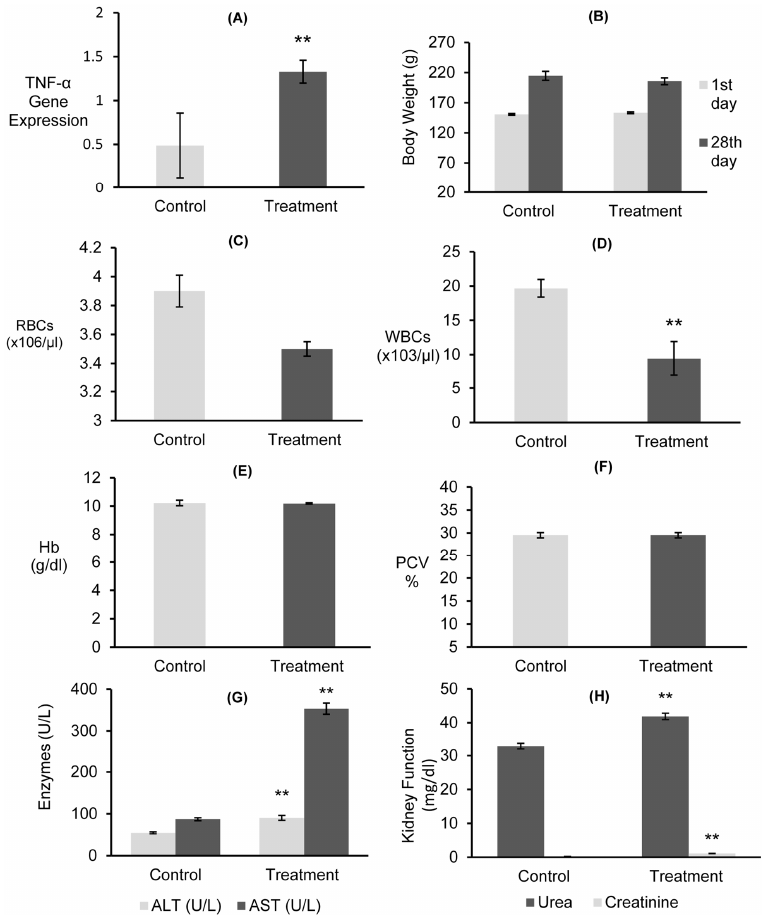
Figure 6. Toxic effects of the crude extract of combined Alternaria mycotoxins (ALT, AOH, TeA, and AS) on TNF- α gene expression ( A ), body weight ( B ), red blood cells (RBCs) ( C ), white blood cells (WBCs) ( D ), hemoglobin (Hb) ( E ), packed cell volume (PCV) % ( F ), liver enzymatic activity of ala- nine aminotransferase (ALT) and aspartate aminotransferase (AST) ( G ), and kidney functions ( H ) of rats compared to the control. Data are expressed as mean ± SD. Means are * significant at p < 0.05 and ** highly significant at p < 0.01 according to the LSD test.